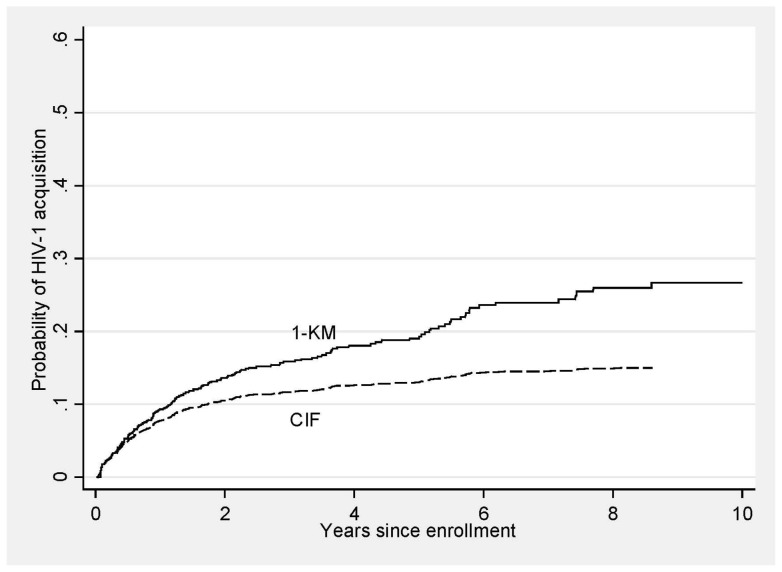
Kaplan-Meier Failure Curve and Cumulative Incidence Function for HIV Acquisition.Note that the failure curve estimates exceed the cumulative incidence function (CIF) estimates at all times during follow-up. The CIF more accurately represents the proportion of enrolled women who acquired HIV-1 infection during follow-up in the study.